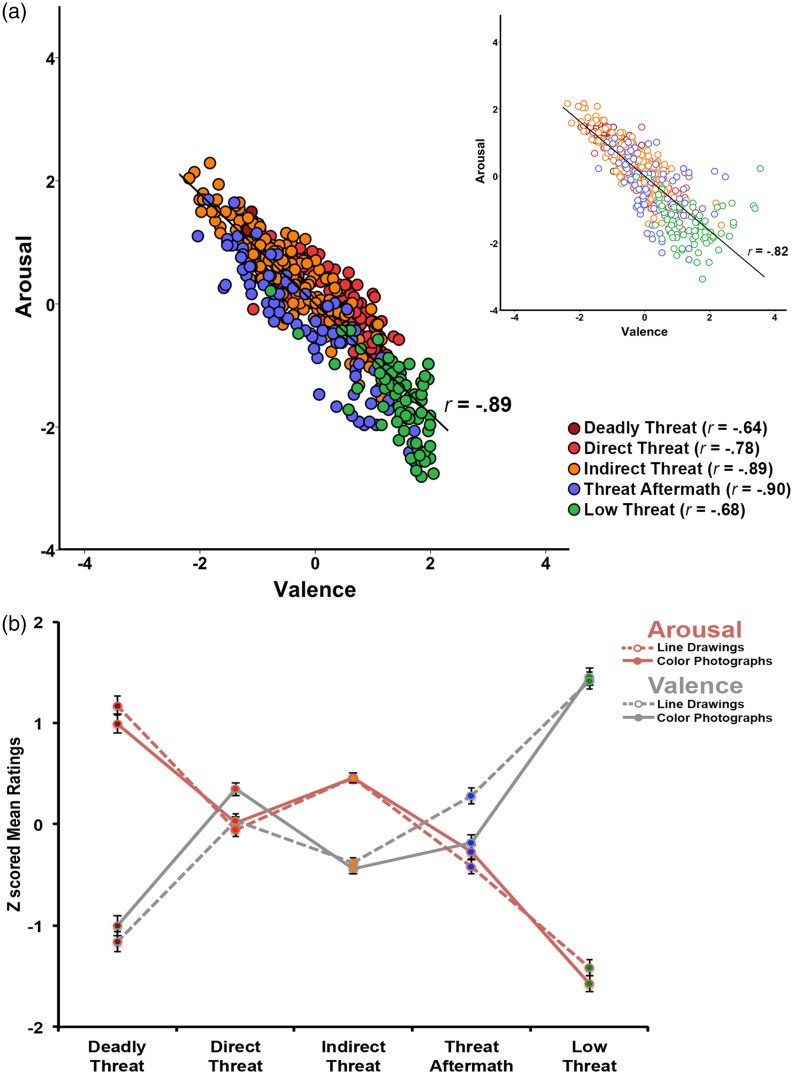
Study 2 validation results. (a) The relationship between valence and arousal ratings of color photographic scenes (left) with the relationship between valence and arousal ratings of line drawings of the matching scenes on the right for comparison. The colors correspond to image categories. (b) Means and SE of valence and arousal ratings for each image category for color photographic images and line-drawing images of matching scenes for comparison.